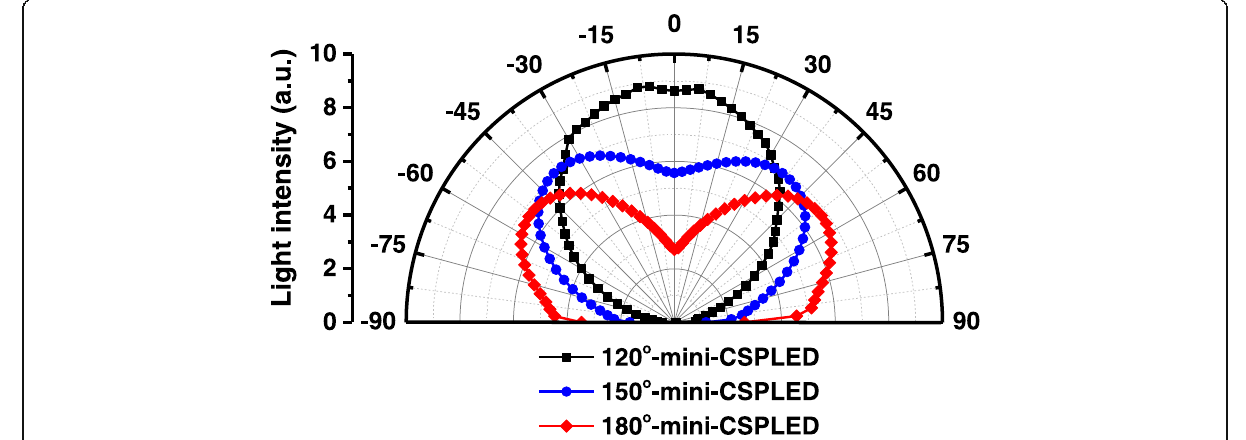
Fig. 5 Radiation patterns of the 120° mini-CSPLED, 150° mini-CSPLED, and 180° mini-CSPLED (at 10 mA)